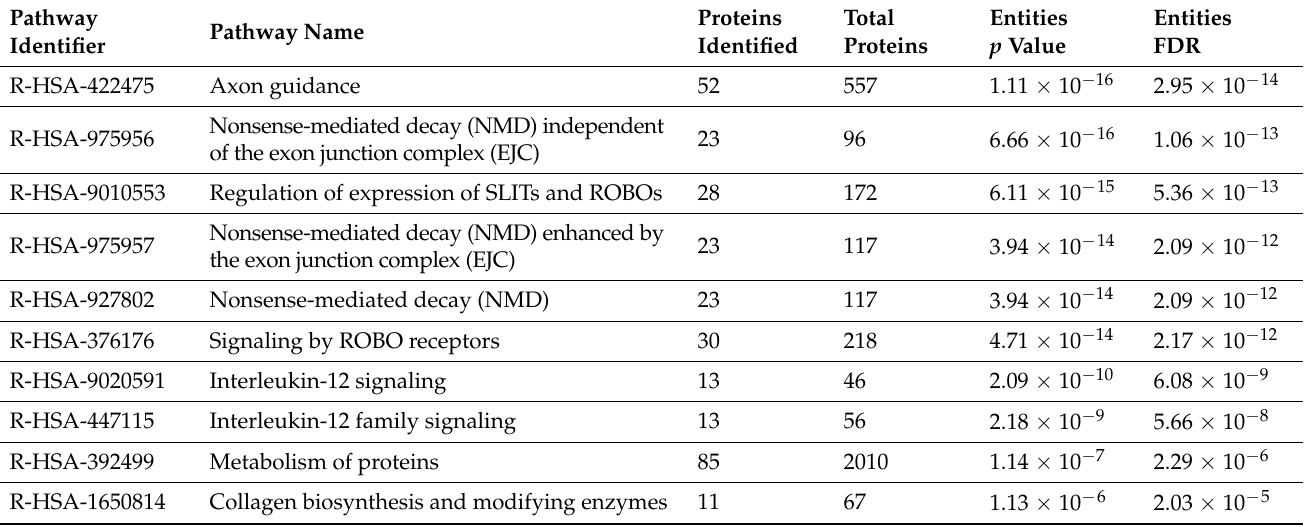
Figure 2. ( A ) Volcano plot analyses for differentially expressed proteins in fibroblasts and myofibroblasts across all four biological replicates (BR1 – BR4). A few important proteins are highlighted in red and labeled in all volcano plots. The volcano plot depicts all statistically significant 269 differentially expressed proteins. The fold-change of differentially expressed proteins on the x-axis vs. the statistical significance ( − log p -value) on the y-axis is shown. ( B ) Hierarchical clustering analysis of 105 proteins (protein coverage 30%) identified in fibroblasts and myofibroblasts in all four biological replicates. The red color represents high gene expression, and blue represents low protein expression. ( C ) The biological classification of 270 proteins into different protein classes is shown as a pie chart with nucleic acid binding and cytoskeletal protein amongst the top ones. Table 1. Reactome analysis depicting the significantly altered pathways during corneal stromal cell